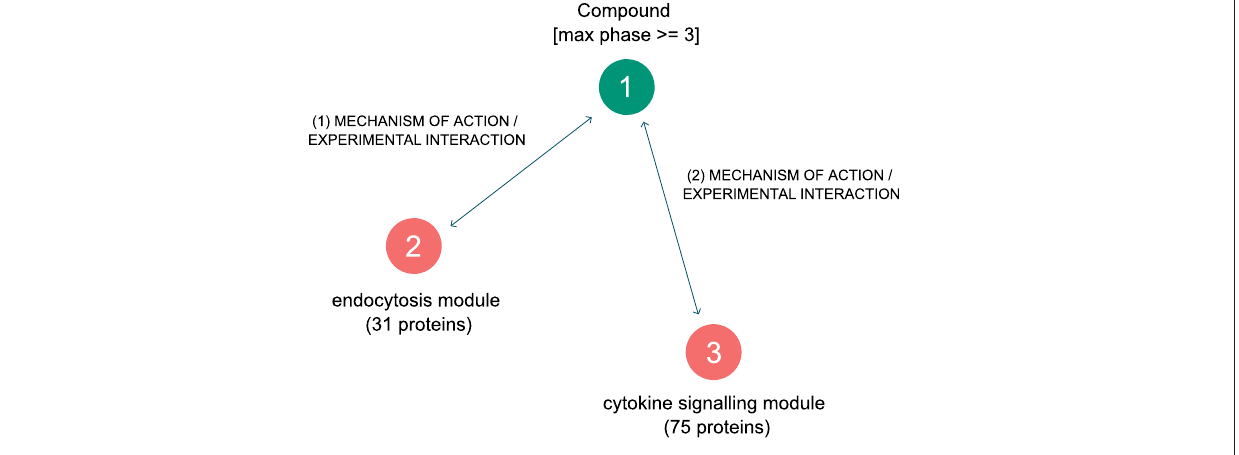
FIGURE 6 | Graph pattern for fi nding approved drugs that are selective and effective against the two hypothesised driving mechanisms behind SARS-CoV-2 induced